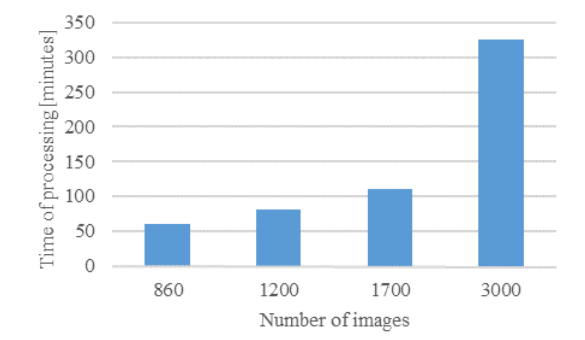
Figure 7. Time of processing (in minutes) in Pix4D depend of number of images (Wroclaw Figure 6. Map of spatial distribution of deviation in tie points height computed with and without nadir images (Katowice dataset).